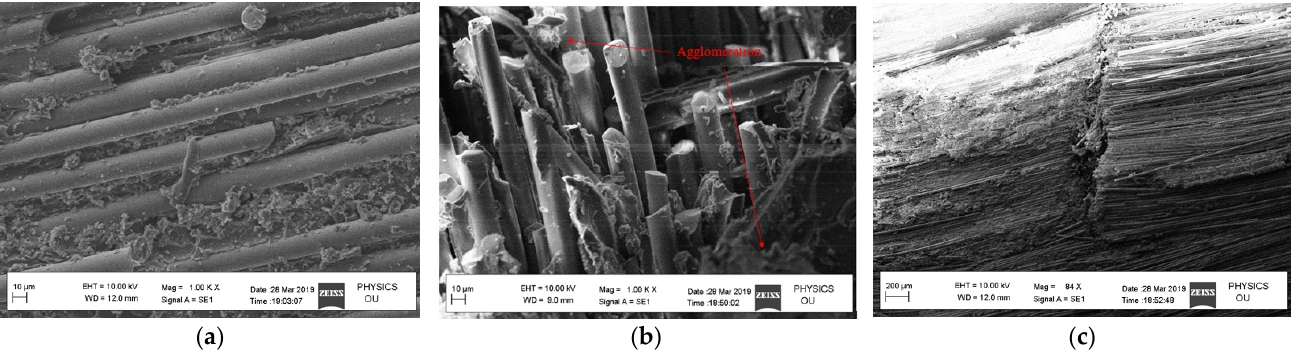
Figure 9. SEM photo of samples: ( a ) tensile load for 0.5 wt% NS, ( b ) tensile load for 0.5 wt% MWCNTs, and ( c ) flexural load for 0.5 wt% NFe.